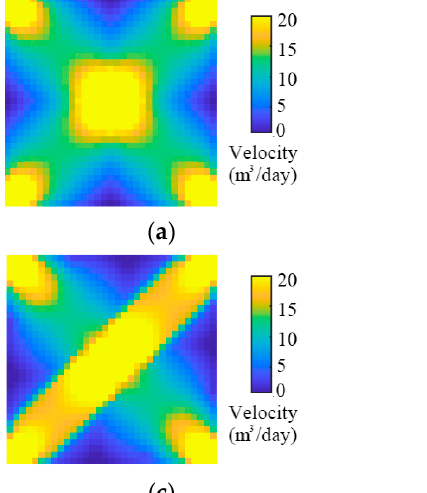
Figure 11. Lateral velocity profiles of synthetic models with different permeability strips. ( a ) Homo- geneous distribution; ( b ) vertical distribution; ( c ) diagonal distribution; ( d ) block-like distribution.